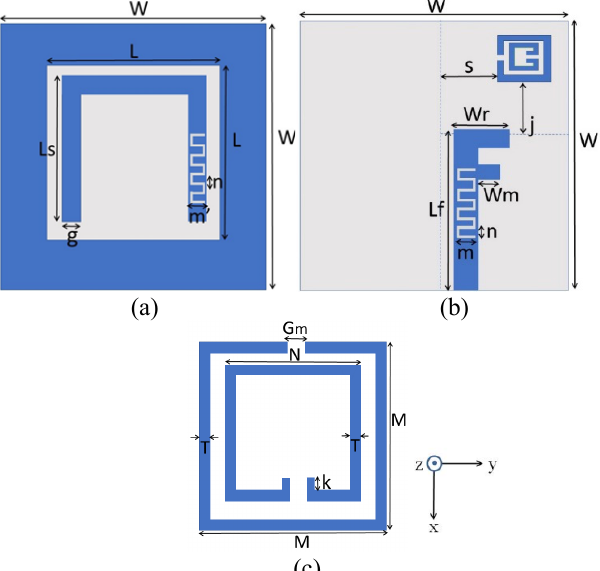
Figure 1: Geometry of the proposed multiband antenna (a) top view (b) side view (c) SRR structure. [L=33.2, W=50, Wr=9.6, Wm=5.3, Lr=18, Lm=25, Lf=31.2, g=4, r=2, Wf=3.6, s= 8.6, j=8.4, k=1.65, M=6, N=4, T=0.6, Gm=0.6, h=1.56, m=3, n=1.4, m’=3.6, width of meander= 0.2], All in